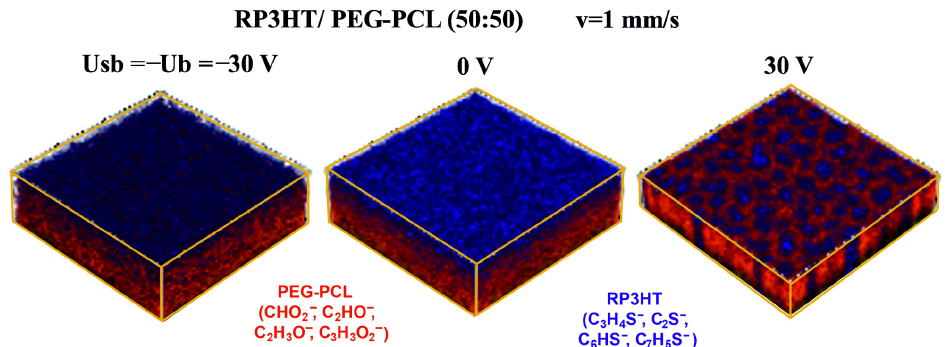
Figure 4. Effect of E-field orientation on the component distribution in the H-dip-coated film of the binary composite RP3HT/PEG-PCL (50:50), with the morphology switched between overall lamellar and lateral structures. Spatial distribution of composite components (RP3HT, blue and PEG-PCL, red), determined with 3D ToF–SIMS for the composite coated with the E-field changed between the opposite orientations, with a zero field interval between both regimes, controlled by the voltage Usb ( t ) between the substrate and barrier. The depth from the original surface is measured based on the sputtering time.